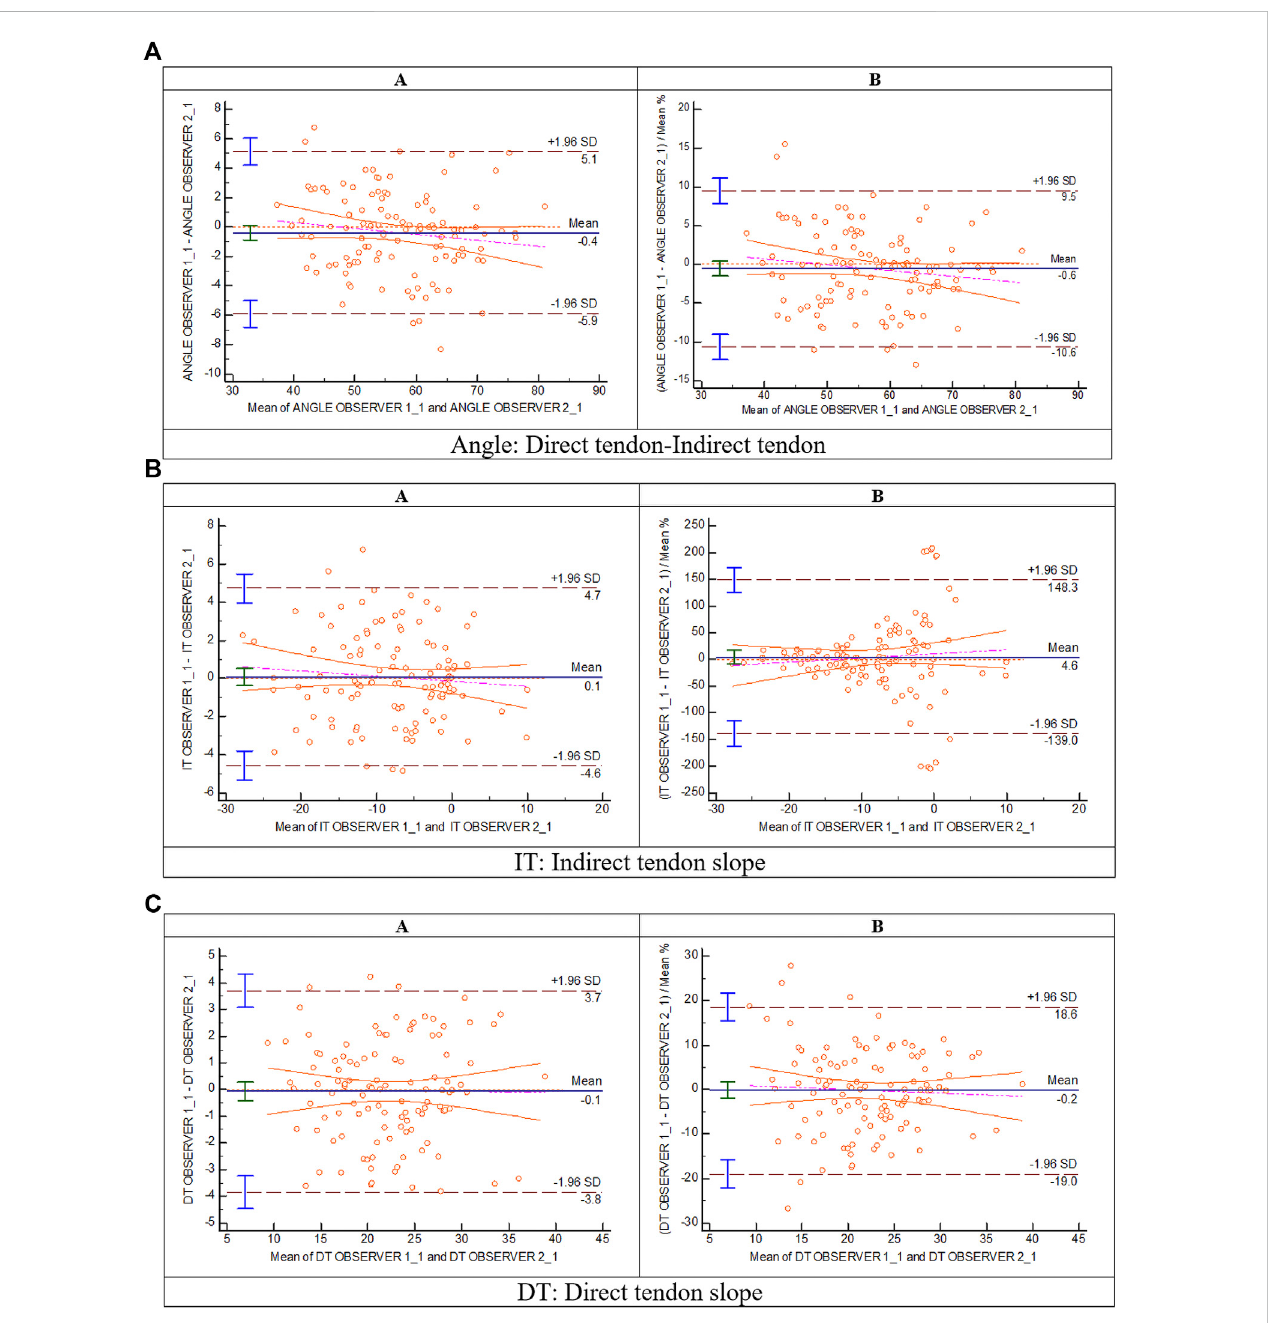
FIGURE 6 Bland and Altman: inter-observer analysis (A: Bland and Altman plot; (B) plot of differences between observer 1 and observer 2 as percentages of the values on the axis vs . the mean of the two measurements) for (A) direct tendon – indirect tendon angle, (B) indirect tendon slope, and (C) direct tendon slope.